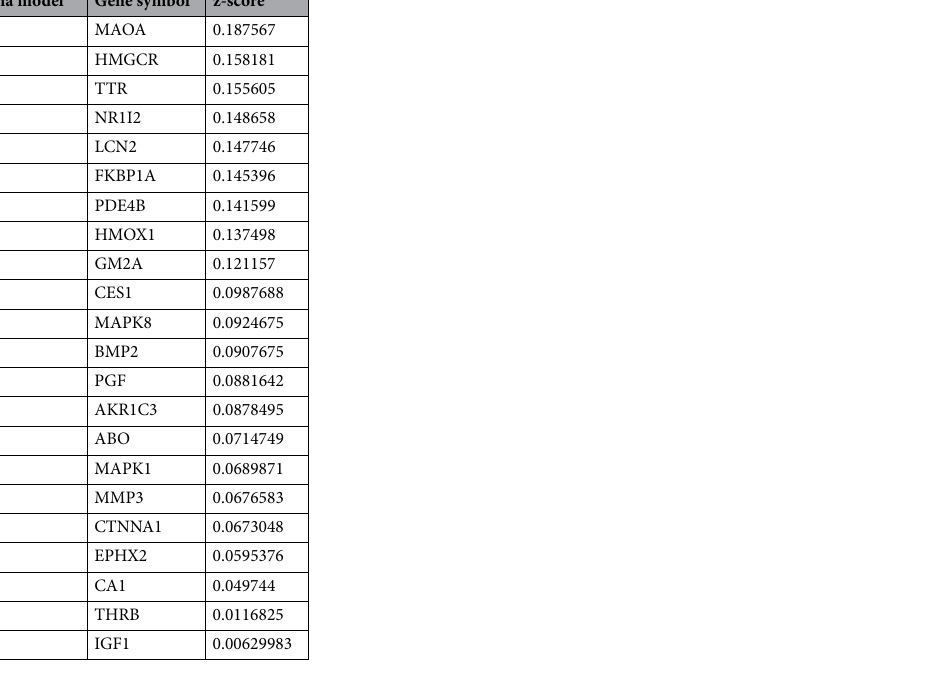
Table 1. Prediction targets of fucosterol.